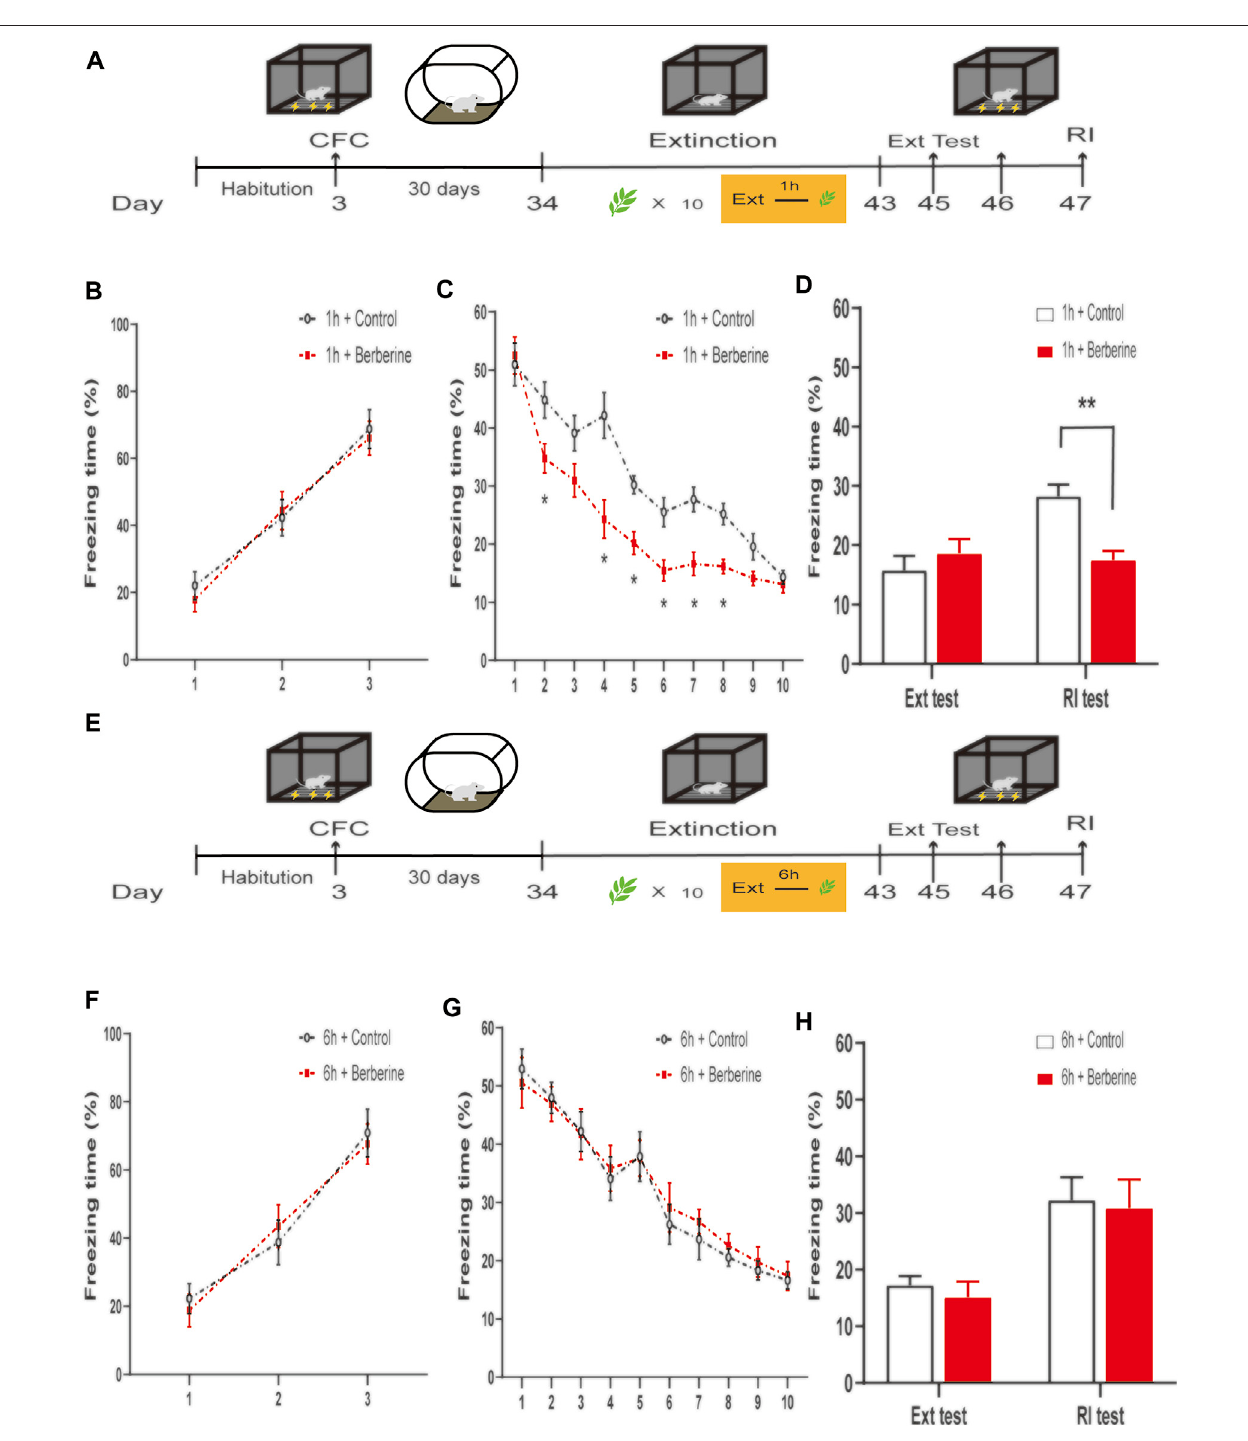
FIGURE 3| Berberine treatment 1 h after extinction enhanced extinction and reduced reinstatement of remote fear. (A, E) Timeline of contextual fearconditioning, drugtreatment,extinctiontraining,extinctiontest,andreinstatementtest. (A) Onehouror (E) 6 haftereachextinctiontrainingsession,cornoil(1 ml/kg,i.g.)orberberine (25 mg/kg,i.g.)wasadministeredtomice,respectively. (B,F) Freezinglevelsduringfearconditioningweresimilarbetweendifferentgroups. (C,G) ThirtydaysafterCFC, freezing behaviors declined during extinction training sessions. (C) Repeated-measures ANOVA, effect of the training day, F (9,126) = 233.4, p < 0.001; Bonferroni post hoc test, p < 0.05, during extinction training days 2, 4 – 8. (D, H) Percentage of freezing time during extinction test (left) and reinstatement test (right). (D) Signi fi cant freezing time was observed in RI test, p = 0.0027. n = 8 mice per group. Data are means ± SEM, * p < 0.05, ** p < 0.01, and compared with 1 h + control group. CFC, contextual fear conditioning; Ext, extinction; RI, reinstatement.